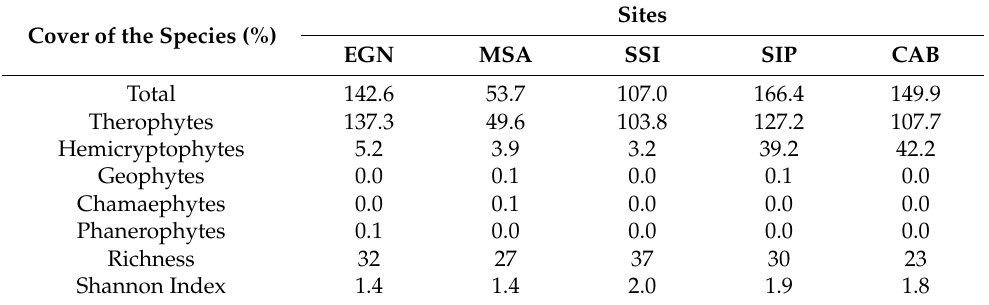
Table 4. Structure of the weed community. Cover of the Species (%)